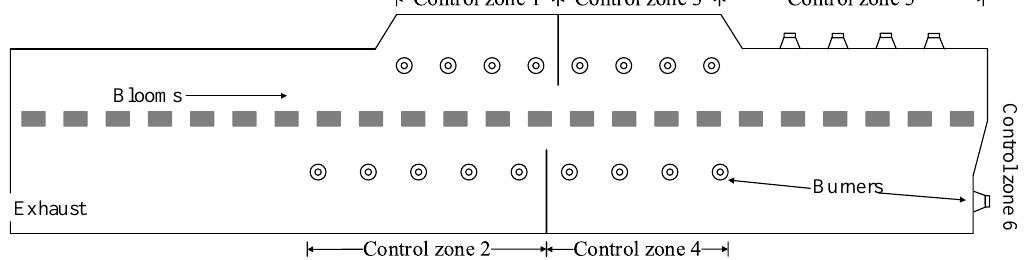
Figure 2 . Outline of the reheating furnace.